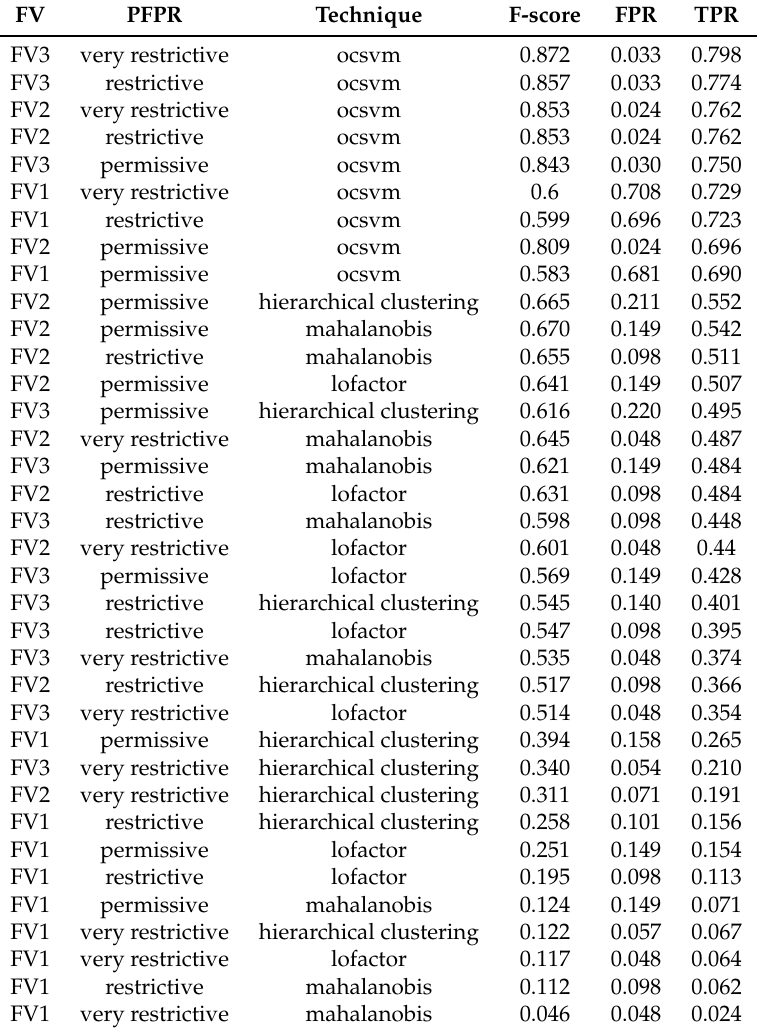
Table 2. Results sorted by TPR using test dataset (b) with samples of all the attacks.